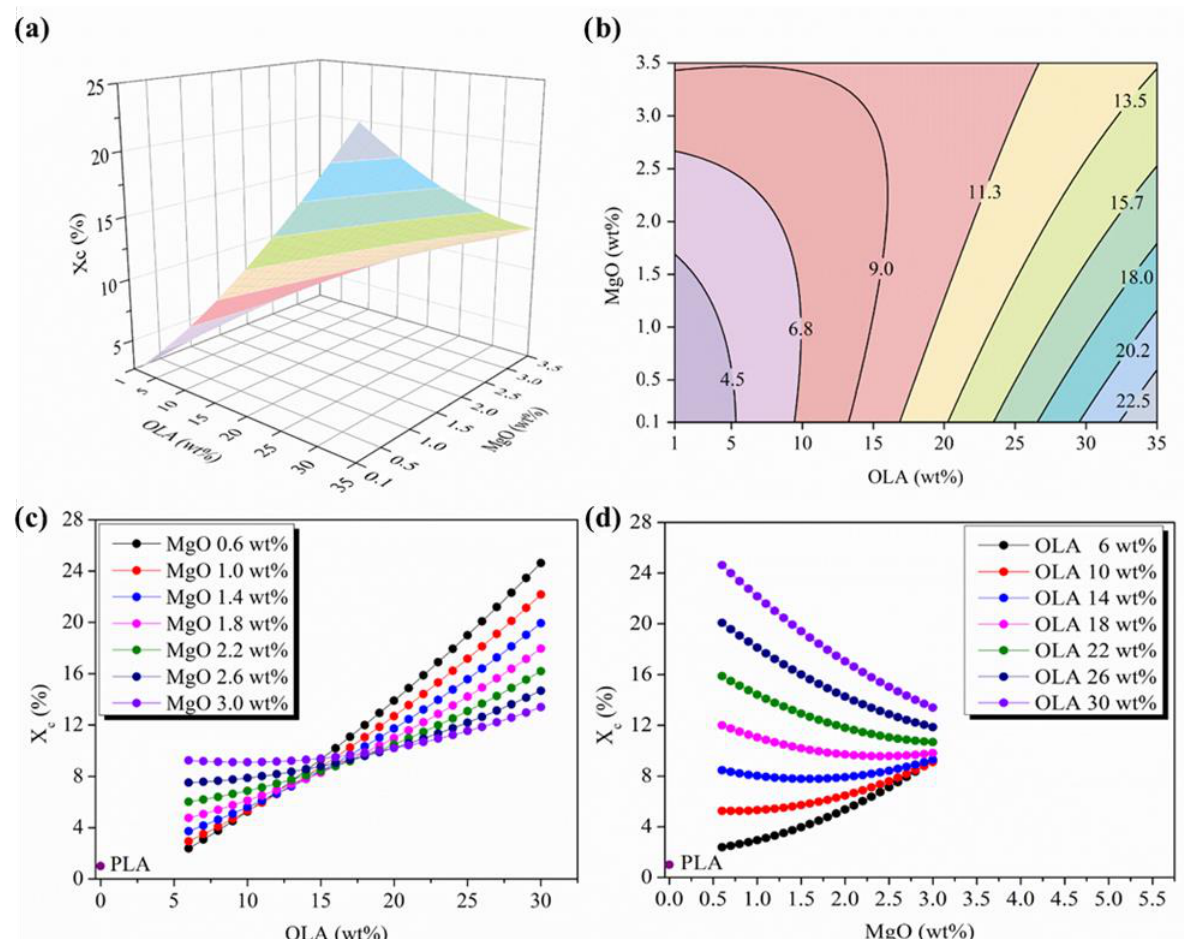
Figure 6. ( a ) Three-dimensional response surface plot and ( b ) contour plot of the degree of crystallinity as a function of OLA and MgO NPs content, colours changes are attributed to an increment of 2.3 % in X c . ( c ) Parametric evolution of the degree of crystallinity with OLA content for different amounts of MgO NPs levels. ( d ) Parametric evolution of the degree of crystallinity with MgO NPs content for different amounts of OLA amounts.